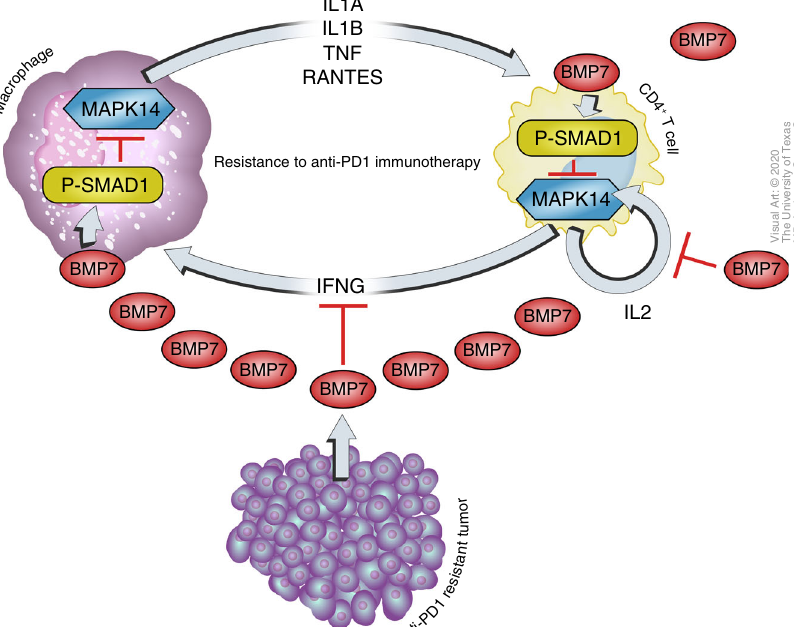
Fig. 6 Work model. Tumors with acquired resistance to immunotherapies secretes BMP7, a member of the TGF β superfamily, repressing macrophage- mediated in fl ammatory responses and Th1-associated cytokines in the tumor microenvironment. BMP7 downregulated MAPK14 and MAPK14-regulated cytokines and chemokines including IL1A, IL1B, TNF, and CCL5 via SMAD1 activation in macrophages. At the same time, BMP7 decreased CD4 + T-cell activation by downregulating IFNG and IL2 expression via SMAD1/ MAPK14 signaling. Taken together, these fi ndings suggest that BMP7 may represent a potential target for therapeutic approaches to overcome resistance to Sequences for the primers used, PCR reactions and cycling conditions in this study are provided in Supplementary Table 2. We measured levels of DNA methylation as the percentage of bisul fi te-resistant cytosines at CpG sites by pyrosequencing with the PSQ HS 96 Pyrosequencing System (Biotage, Charlottesville, VA) and Pyro Gold CDT Reagents (Biotage).